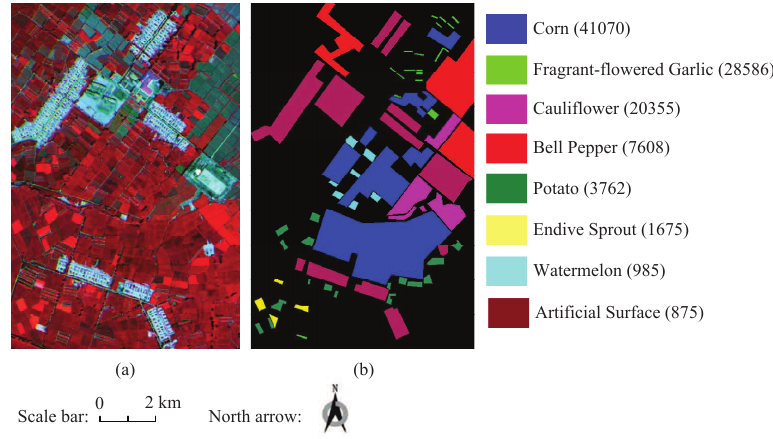
Figure 3. Heihe hyperspectral image. ( a ) HSI in false-color; ( b ) Ground-truth